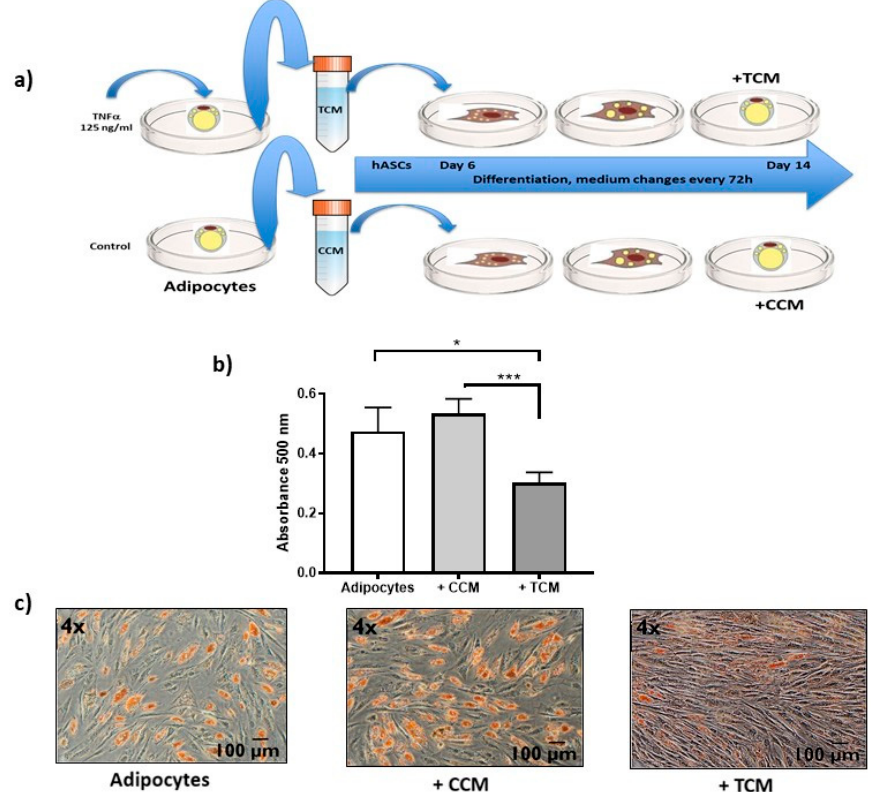
Figure 6. Effects of SASP on adipogenesis. ( a ) Experimental design followed to know the effect of the secretome on surrounding cells. Untreated (CCM) and TNF α -treated (TCM) adipocyte medium was harvested. The differentiation of hASCs was started six days prior in optimal conditions (as described in materials and methods) until day 6 of culture. The preadipocytes of these cultures were exposed to + CCM or + TCM and differentiation stimuli until day 14 of adipogenesis, changing the medium every 72 h. ( b ) Spectrophotometric quantification at 500 nm of absorbance of lipid droplets identified by Oil Red O staining at the end of adipogenesis, comparing control adipocytes with those treated with + CCM and + TCM. Three independent experiments were carried out. One-way ANOVA test * p < 0.05 and *** p < 0.001 ( c ) 4 × magnification light microscopy images representative of Oil Red O staining. hASCs adipogenesis is not affected by secretions from untreated adipocyte (+ CCM), while the secretions of adipocytes treated with TNF α (+ TCM) limit adipogenesis showing lower staining of lipid droplets with Oil Red